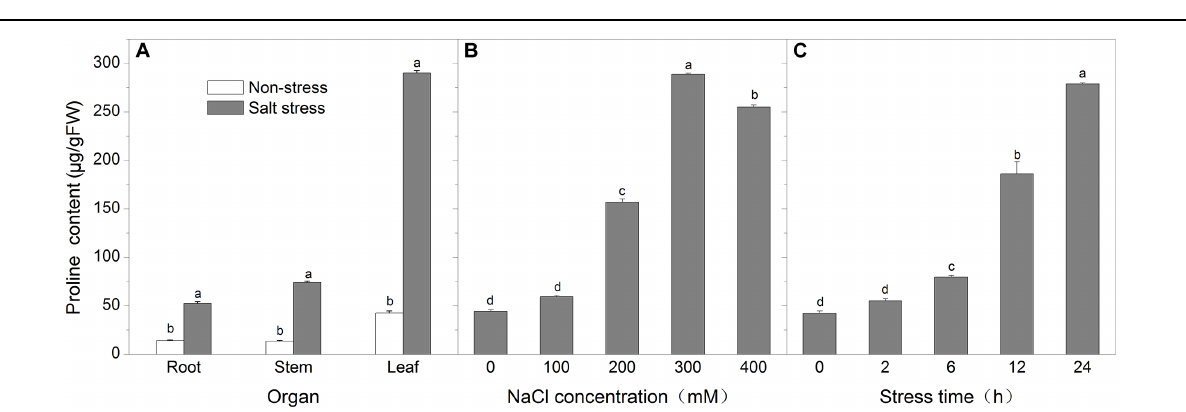
the expression of KvPDH slightly decreased before 12 h and